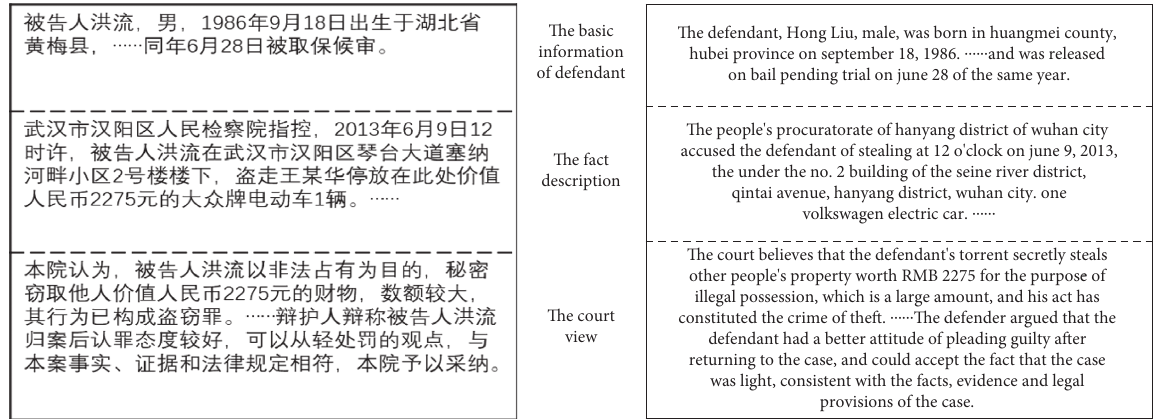
Figure 1: A judgment document example in China (original Chinese text and its English